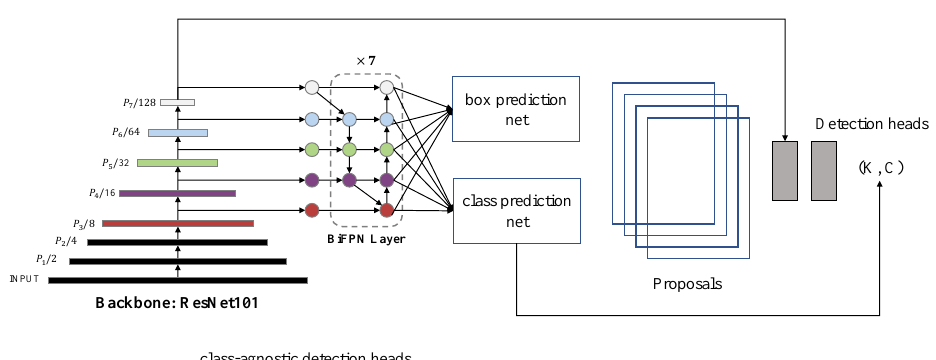
Figure 1. Overview of CenterNet2 architecture.